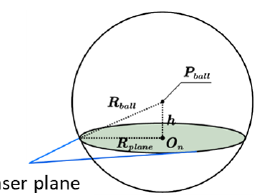
Figure 4. The measurement principle of the line laser